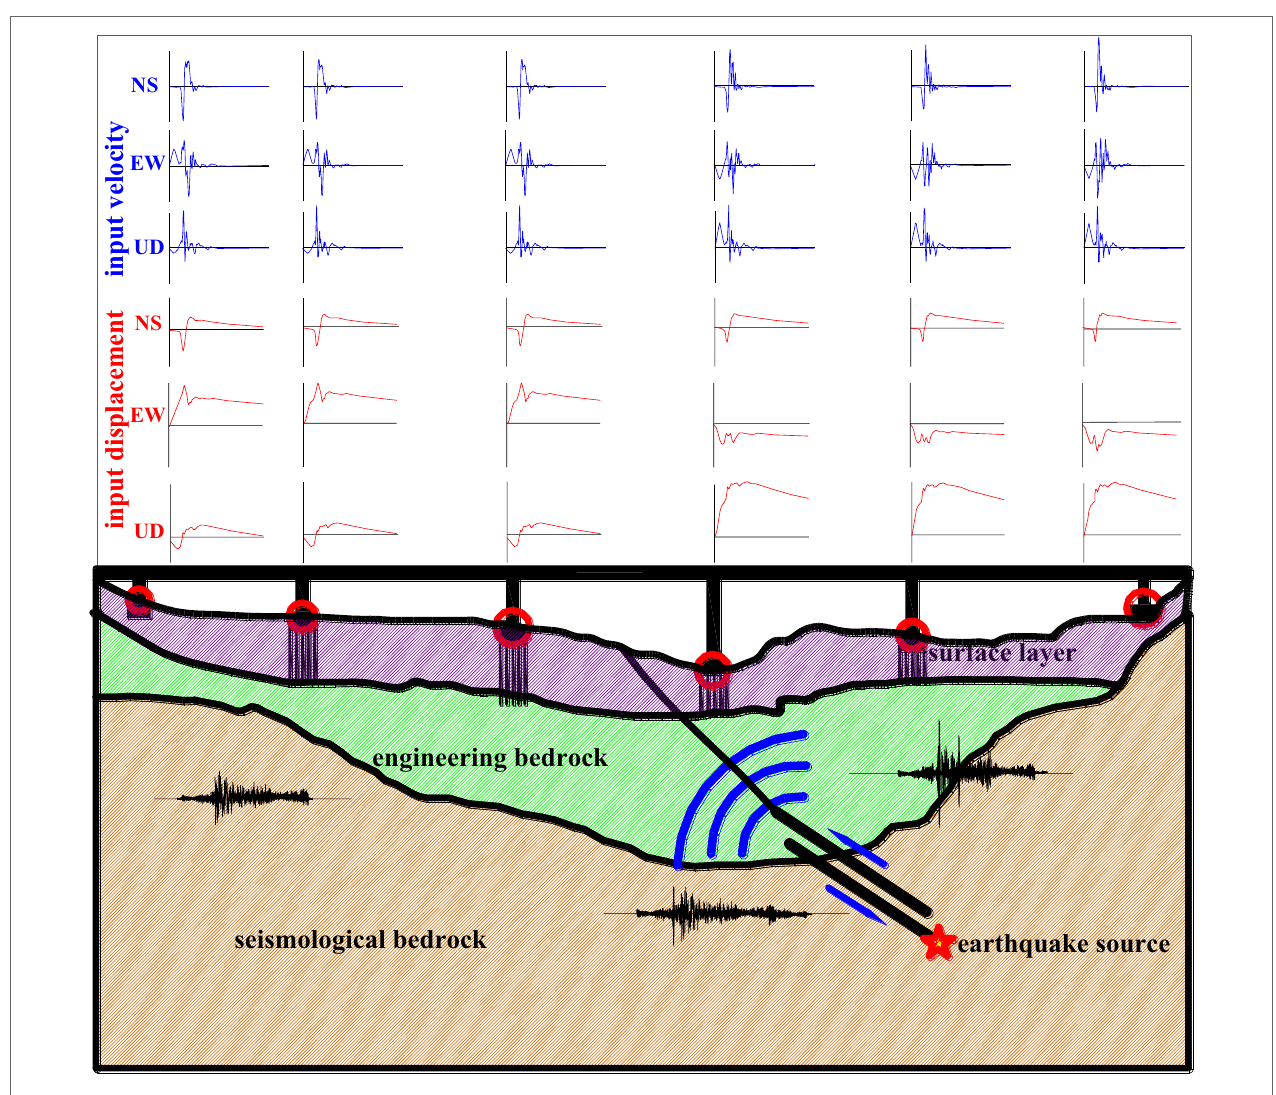
FigUre 1 | input ground displacements for near-fault bridge structures